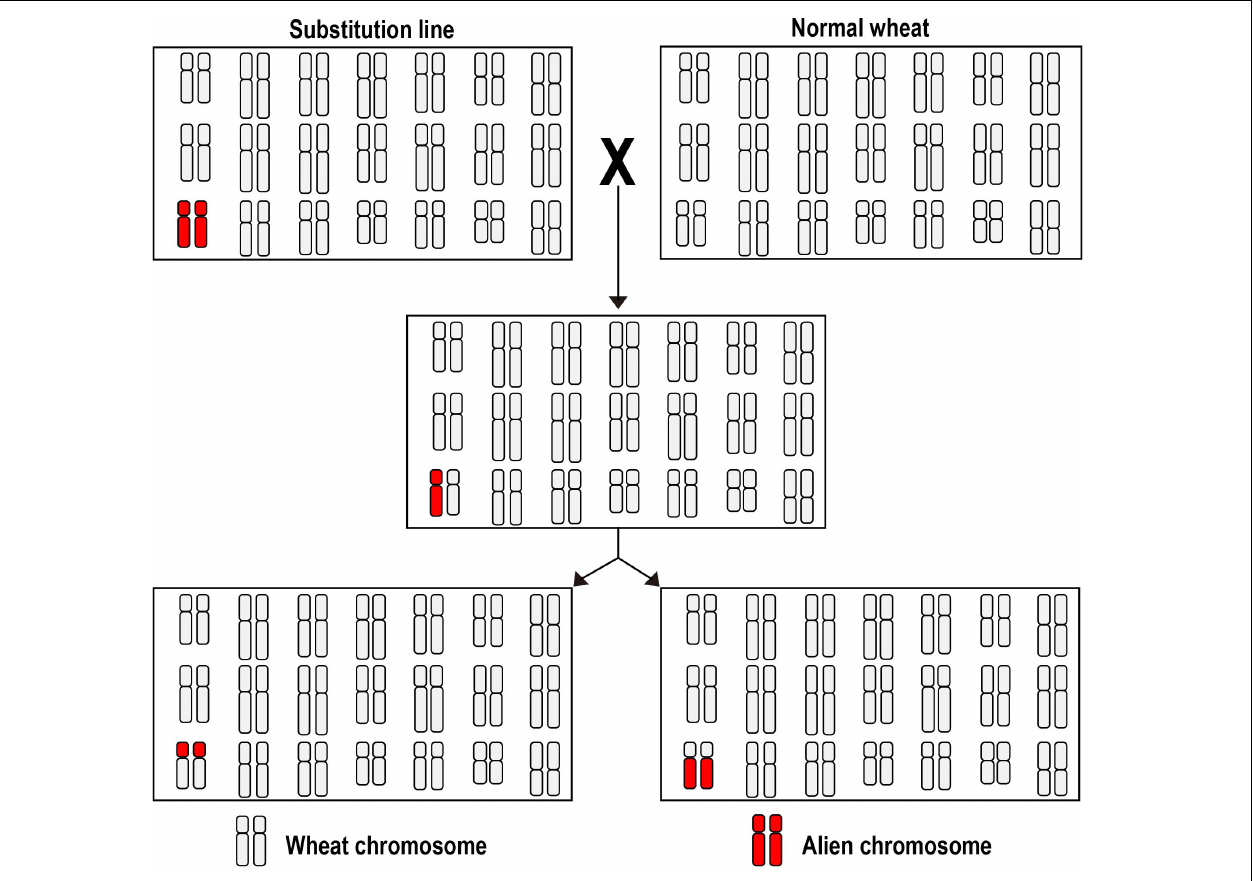
FIGURE 1 | The double monosomic method use to induce cRobTs. A euploid cultivar is crossed with a whole chromosome substitution line in which an exotic chromosome has replaced its wheat homeolog. The resulting F 1 hybrid carries two chromosomes which remain as univalents at meiosis metaphase I, giving the opportunity for a joint breakage/fusion event at anaphase I to create a